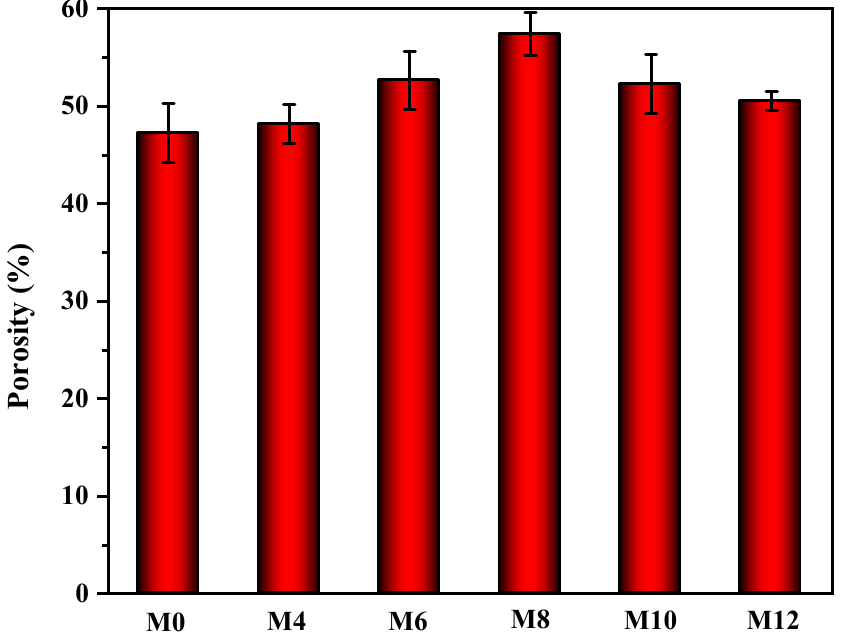
Figure 7. The porosity of ZIF-8/PPS fiber membranes (M0: untreated; M4: 4 h; M8: 8 h; M10: 10 h; M12: 12 h).